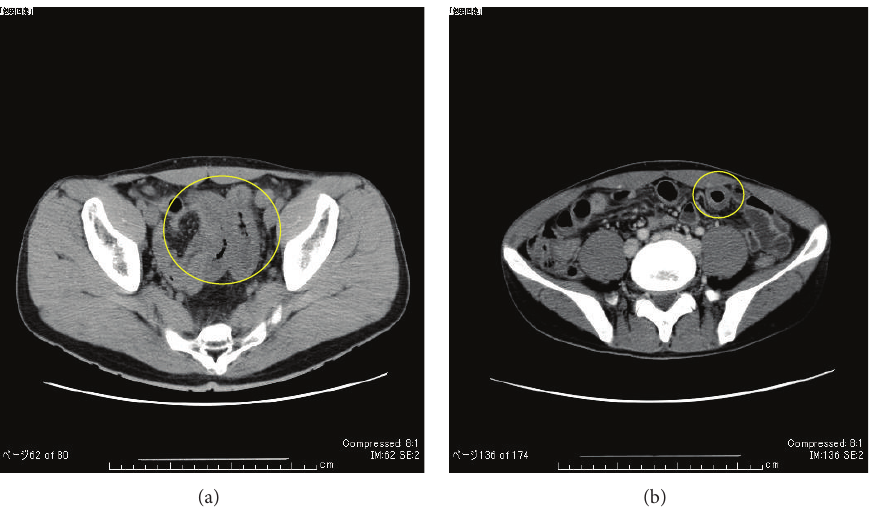
Figure 1: (a) CT scan in December 2009; thickening of small intestine wall is circled. (b) Contrast-enhanced CT scan in February 2010; edema-like contrast effect of intestinal wall thickening is